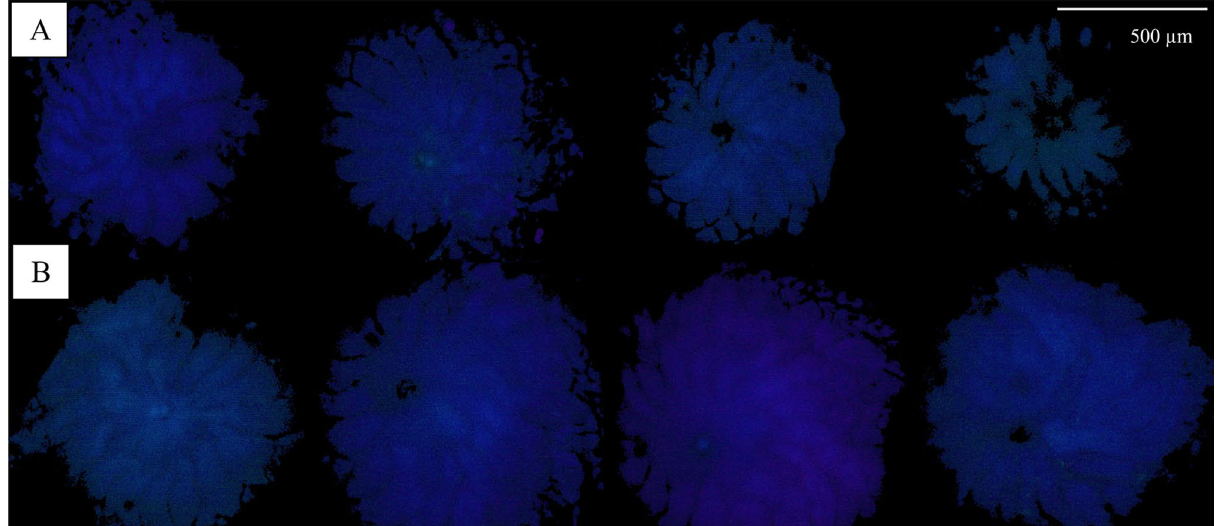
Figure 1. Evaluated PAM-images recorded the change of photosynthetic active areas with time (left to right: 0, 1, 3, and 7 days). The first images ( A ) are an example for a sample which contain sunscreen (in this case sunscreen D50, see Table 2). The second one ( B ) shows the variation of the